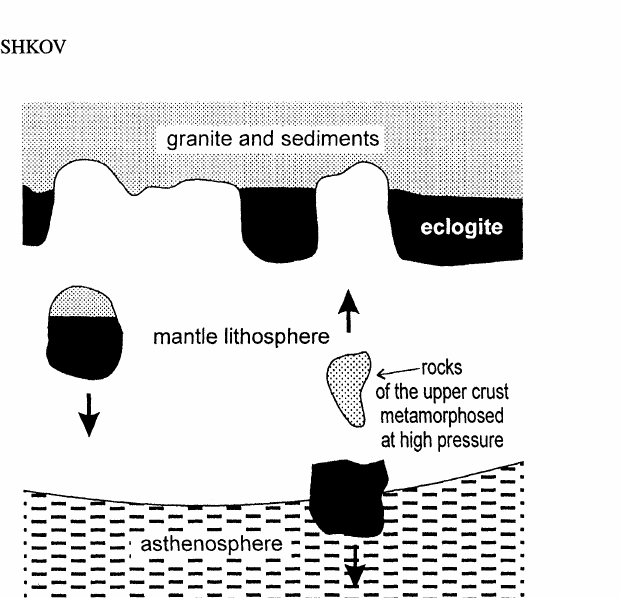
FIGURE 7 Sinking of blocks of dense eclogite into the mantle lithosphere at the epochs of lithospheric softening and strong compression ofthe crust in fold belts. Delamination of minor blocks of light rocks of the upper crust with high pressure minerals (diamond and coesite), which were formed at a large depth, and their rapid ascent through the mantle lithosphere to the